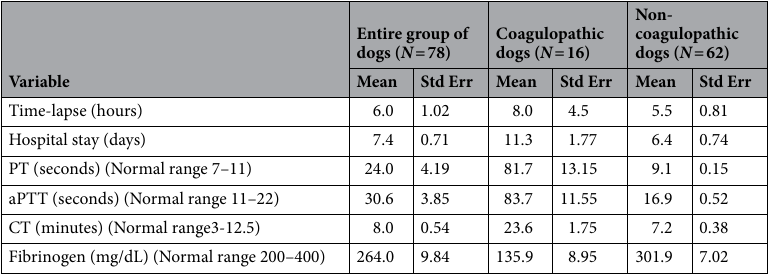
Table 2. Demographic and clotting parameters variation of dogs with HNV bite envenoming. ( Std Err . Standard Error).